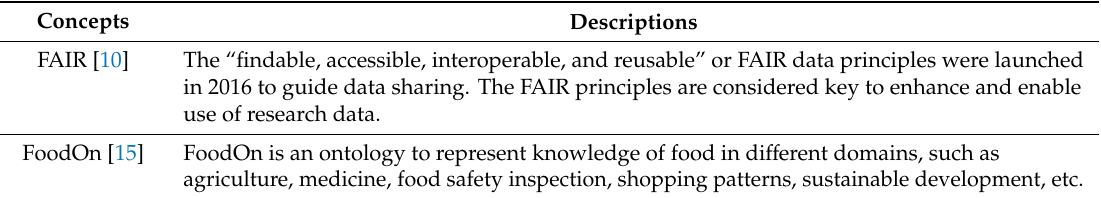
Table 1. Key concepts used in the